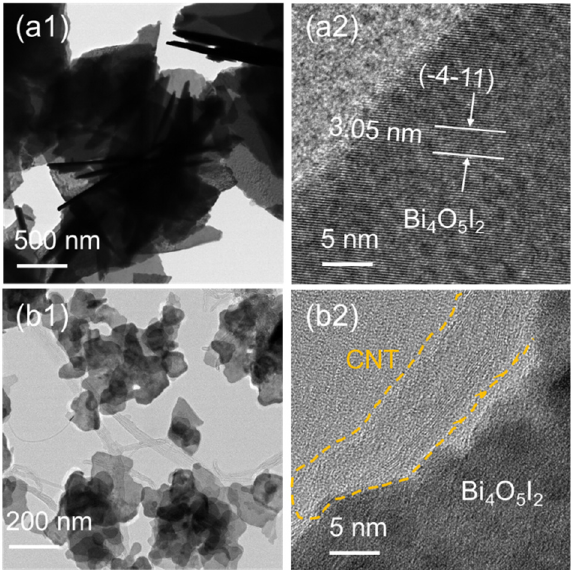
Figure 2. HRTEM images of ( a1 , a2 ) Bi 4 O 5 I 2 and ( b1 , b2 ) 15% CNT/Bi 4 O 5 I 2 composite.